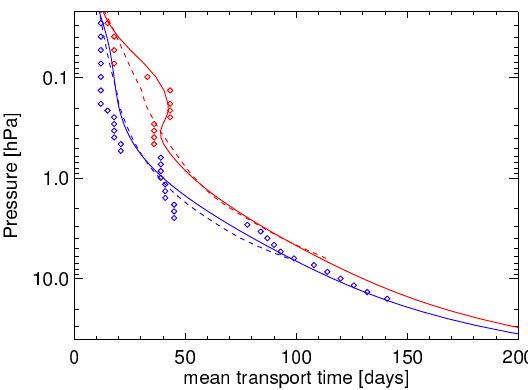
Figure 1. Mean transport times from the EPP source region to the indicated pressure level in the SH (blue diamonds) and NH (red dia- monds, only above 0.5hPa) as derived from the best-fit mean value (cid:48)(z) of the inverse Gaussian used as an A p weighting function. Transport times derived from the mid-winter vertical velocities of Funke et al. (2014b) are shown by dashed lines. Solid lines corre- spond to the transport times expressed as a function of t N m (z) , used in the semi-empirical